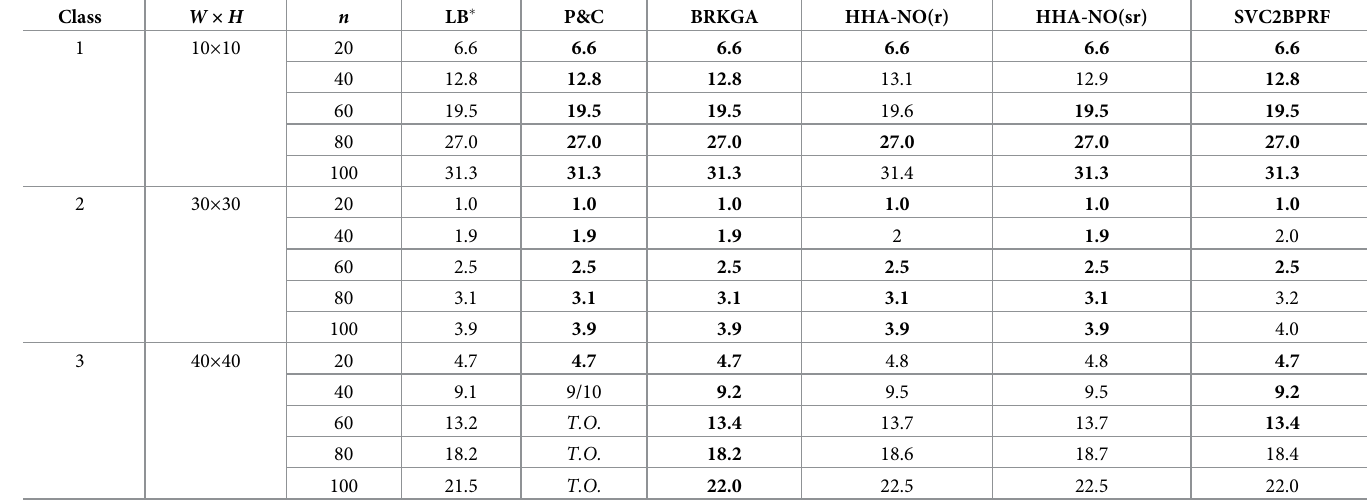
Table 12. Comparison of the solutions obtained by the different approaches for the bwmv instances when 90˚ rotation of the items is allowed. Class W × H n LB �